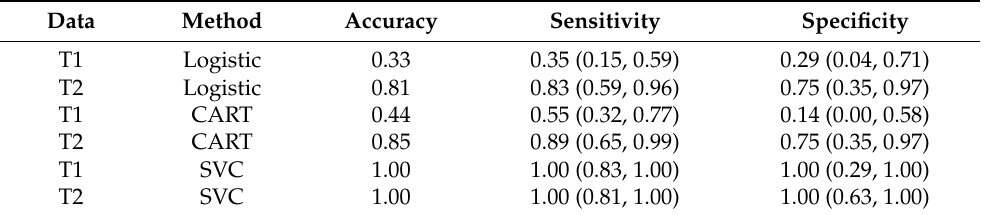
Table 6. Classification results for myocardial injury in the whole cohort.